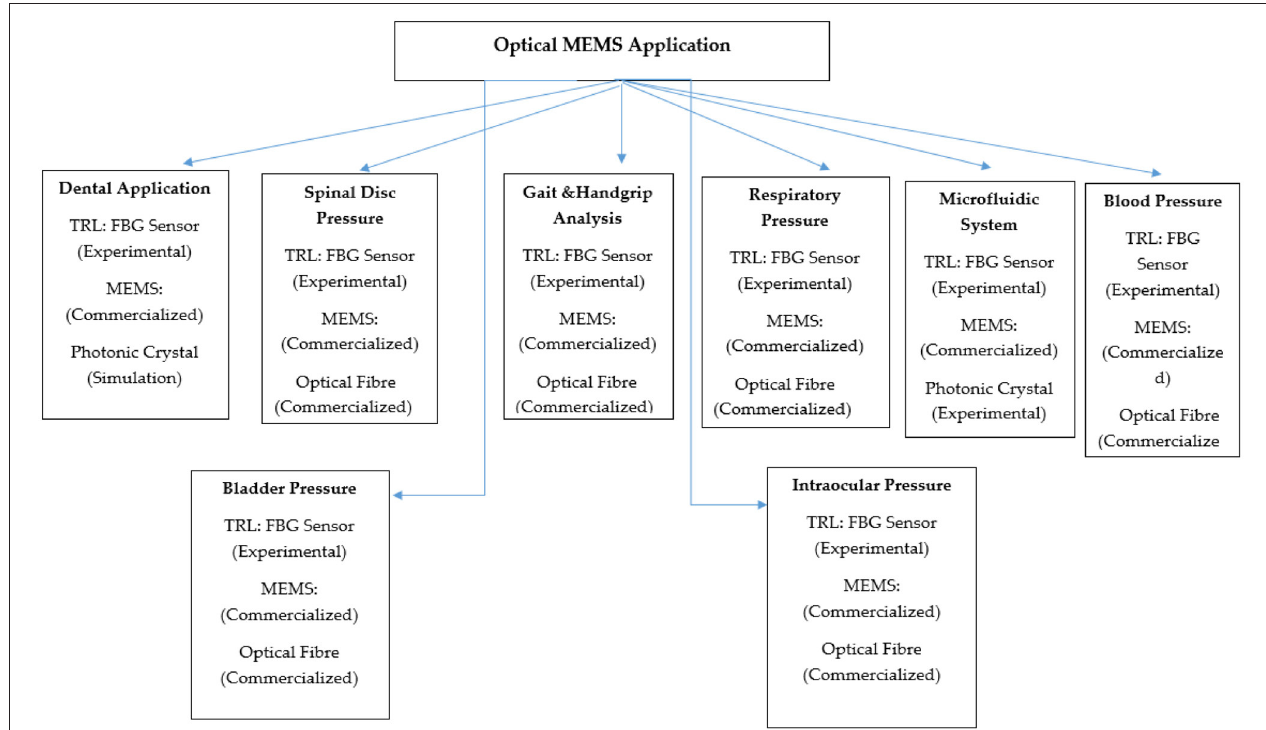
FIGURE 13 | Major applications and TRL (technology readiness level) of optical MEMS sensing system in